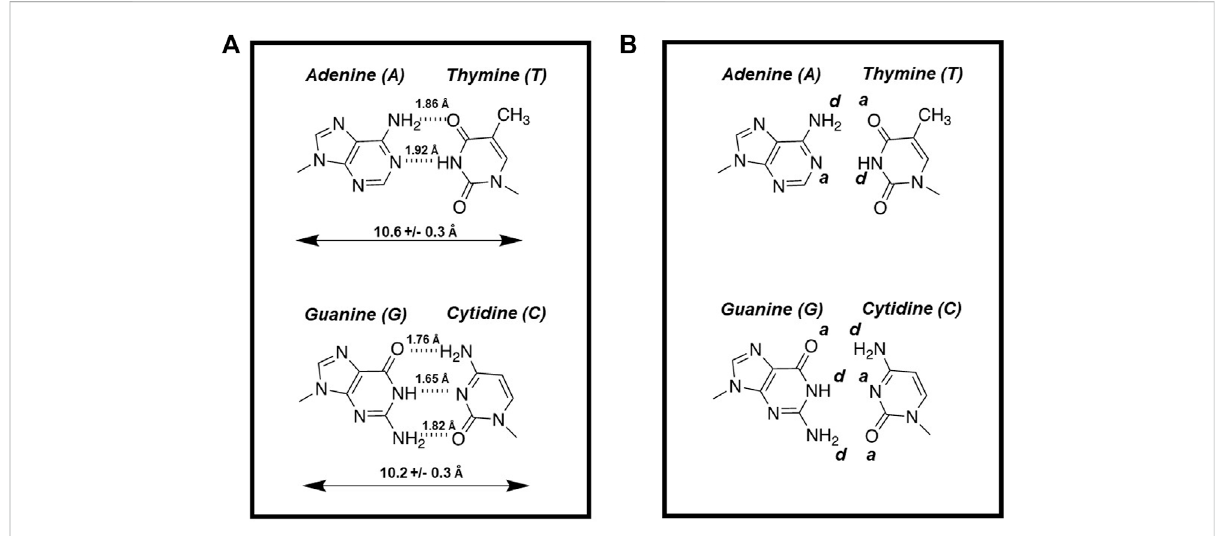
FIGURE 1 (A) Structures of Watson-crick base pairs are stabilized by hydrogen bonding interactions made between the complementary nucleobases. (B) HydrogenbondingpatternsforanA:Tbasepairwhichusescomplementarityofd*a*(-)toa*d*awhileaG:Cbasepairusescomplementarityofa*d*d to d*a*a